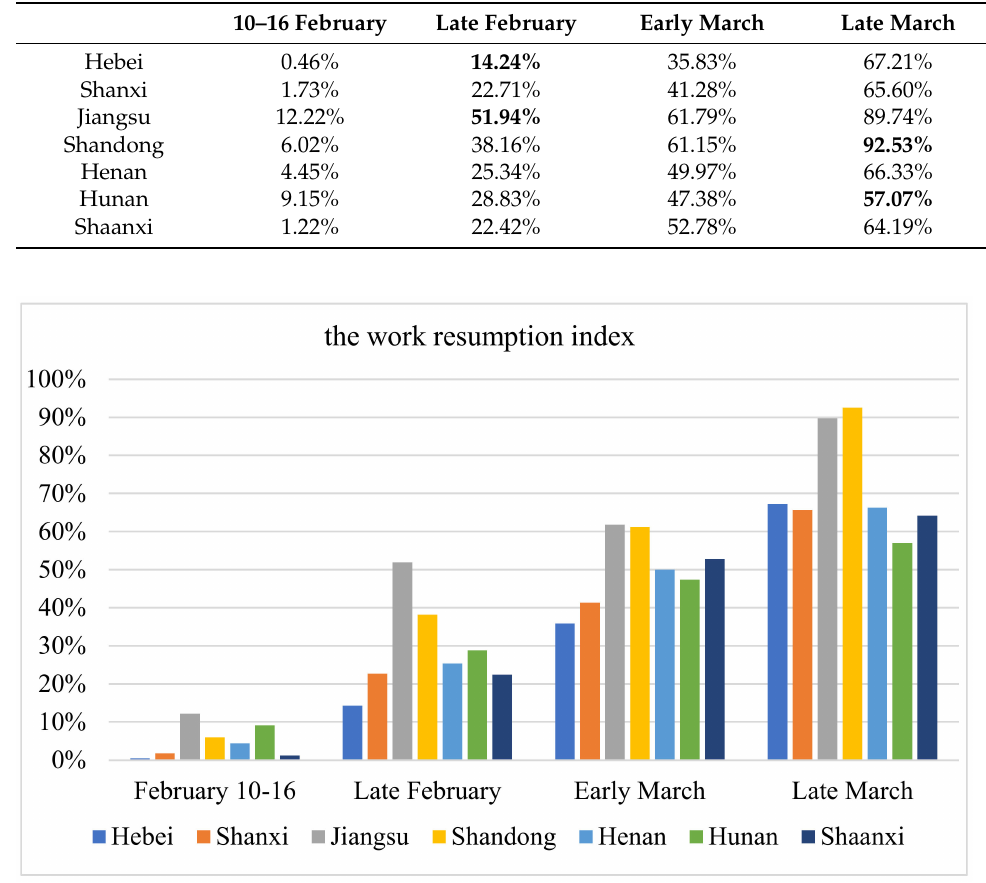
Figure 7. The histogram of the work resumption index of 7